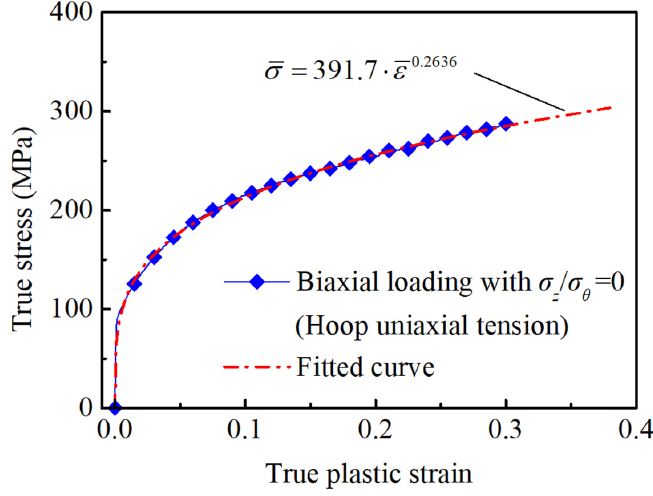
Figure 6. Stress–strain curve of the AA6061 tube in hoop direction.